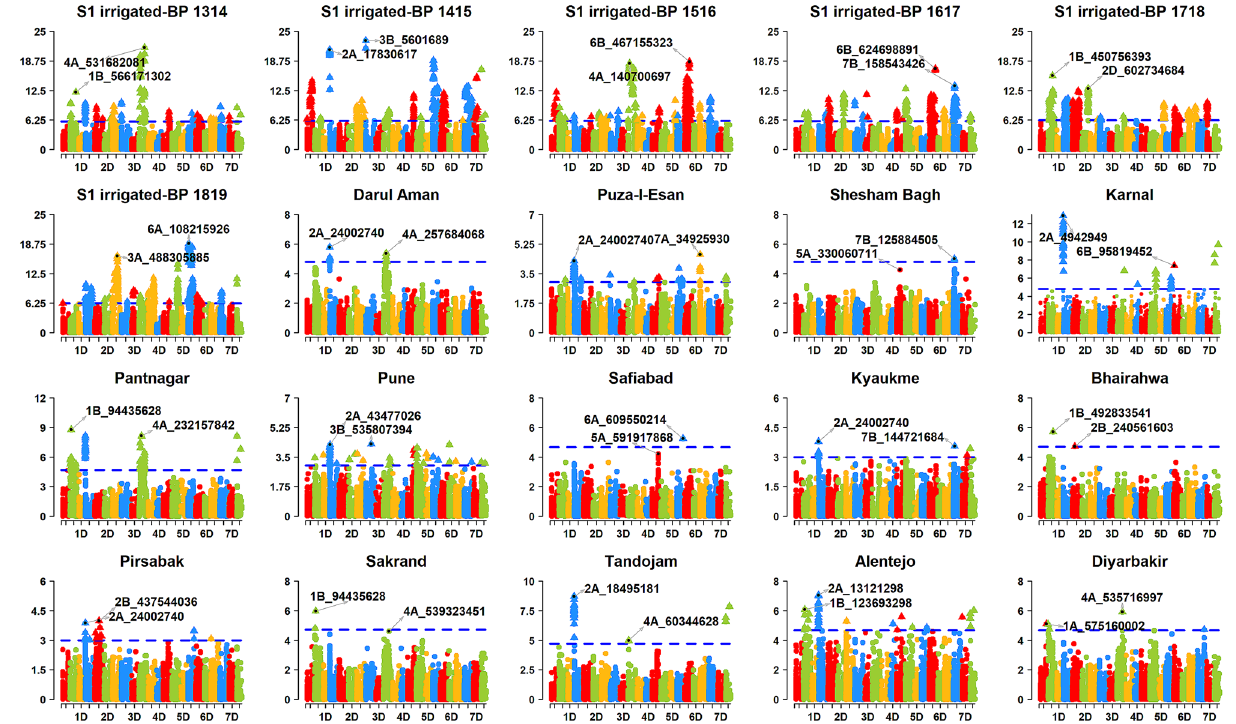
Figure 2. Markers significantly associated with grain yield in the Stage 1 (S1) yield trials evaluated in the irrigated-bed planting (BP) environment at Obregon (Mexico), during the 2013–2014 (S1 irrigated-BP 1314), 2014–2015 (S1 irrigated-BP 1415), 2015–2016 (S1 irrigated-BP 1516), 2016–2017 (S1 irrigated-BP 1617), 2017– 2018 (S1 irrigated-BP 1718) and 2018–2019 (S1 irrigated-BP 1819) crop cycles and in the combined analysis of grain yield evaluated in the international sites (Darul Aman, Puza-I-Esan and Shesham Bagh in Afghanistan; Karnal, Pantnagar and Pune in India; Safiabad in Iran; Kyaukme in Myanmar; Bhairahwa in Nepal; Pirsabak, Sakrand and Tandojam in Pakistan; Alentejo in Portugal and Diyarbakir in Turkey) during some of the crop cycles between 2003 and 2017. The chromosomes are shown in the x-axis and the − log 10 p values in the y-axis. The threshold lines for the S1 yield trial datasets and the international sites datasets correspond to the threshold using the Bonferroni correction for multiple testing at an α level of 0.01 and 0.20,